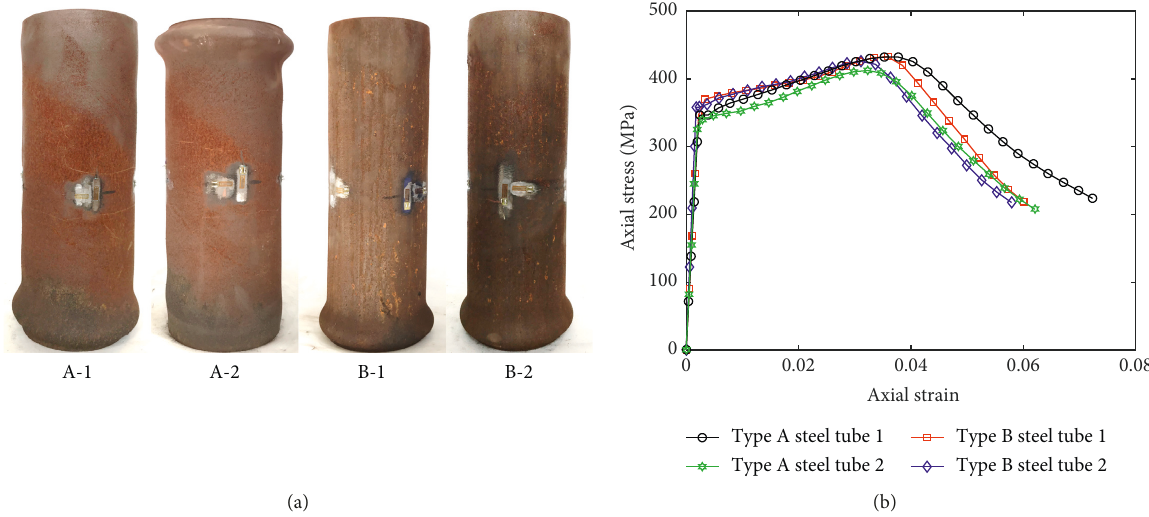
Figure 9: Hollow steel tubes under axial compression. (a) Local buckling of hollow steel tubes. (b) Axial stress-strain curves.